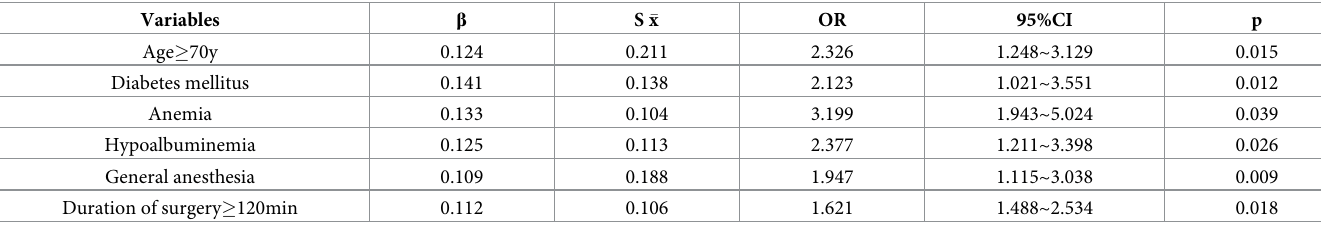
Table 3. Logistic regression analysis on the risk factors of postoperative pulmonary infection in elderly patients with hip